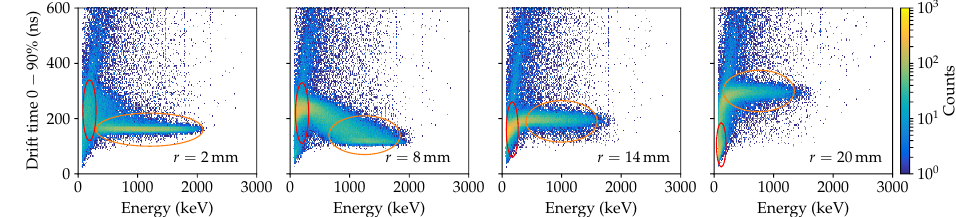
Figure 15. Correlations between the drift time (0–90%) and E obs orange horizontal ellipses in the distributions indicate two event